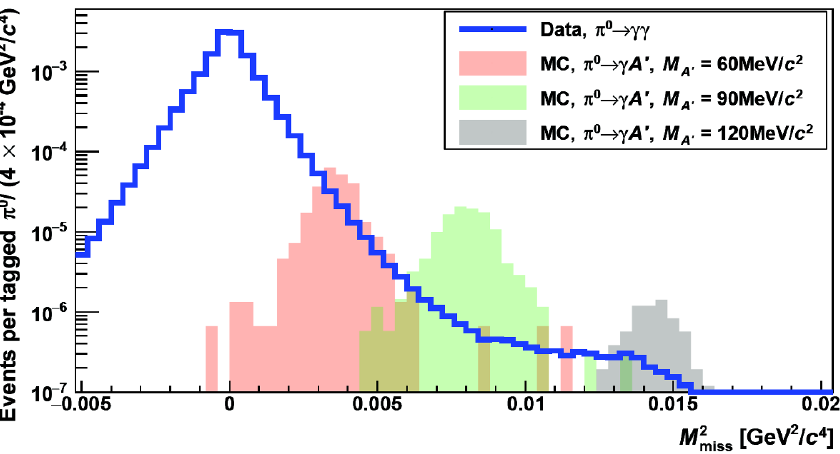
Figure 2 . Distributions of the squared missing mass evaluated from K + decays with one photon and one (cid:25) + reconstructed (eq. (3.1)). Data from (cid:25) 0 ! (cid:13)(cid:13) with one photon, randomly chosen, assumed to be undetected are shown by the blue line. The expected spectra from MC simulations of (cid:25) 0 ! A 0 (cid:13) with a coupling strength (cid:15) 2 = 2 : 5 (cid:2) 10 (cid:0) 4 and A 0 masses of 60 (red), 90 (green) and 120 MeV/ c 2 (grey) are also shown. For details about the normalization used, see